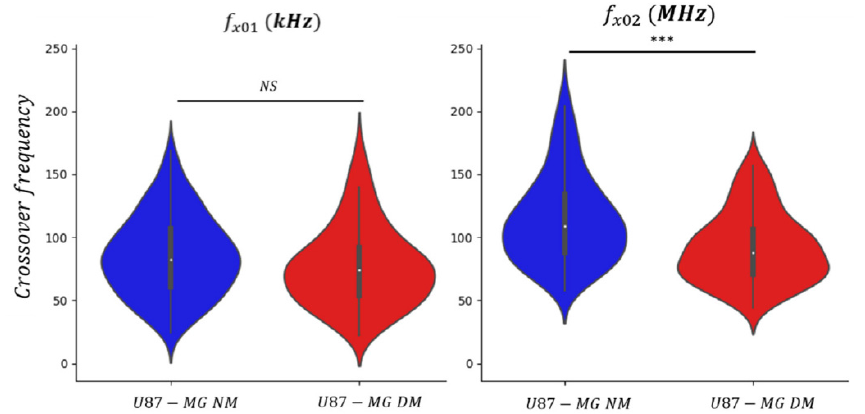
Figure 9. Graphic violin plot representation of U87-MG cells crossover frequencies f x01 (left graph) and f x02 (right graph), cultured in two different conditions: Normal Medium (NM) and define medium (DM). *** represents p -value < 0.0001.